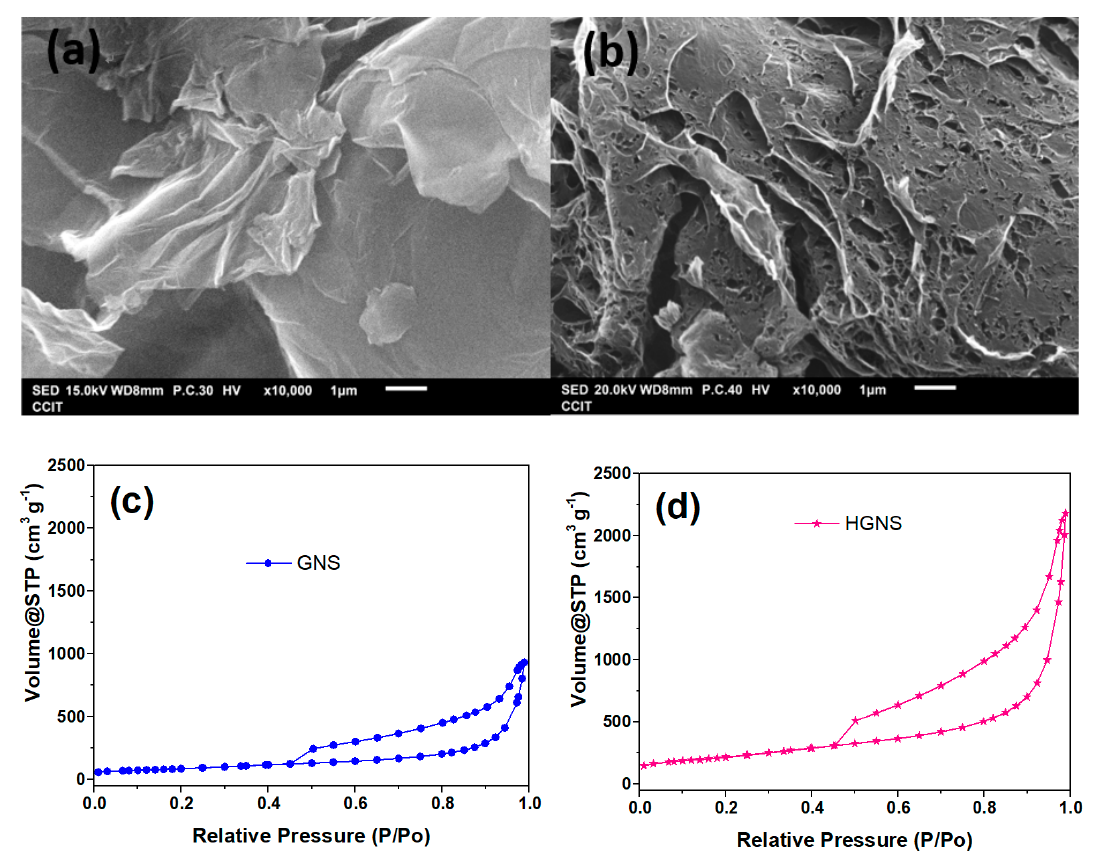
Figure 5. SEM images of ( a ) GNS and ( b ) HGNS; and nitrogen adsorption–desorption isotherm curves of ( c ) GNS and ( d ) HGNS.